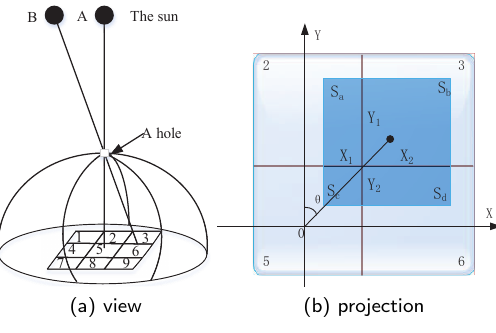
Figure 4. The principle of sun